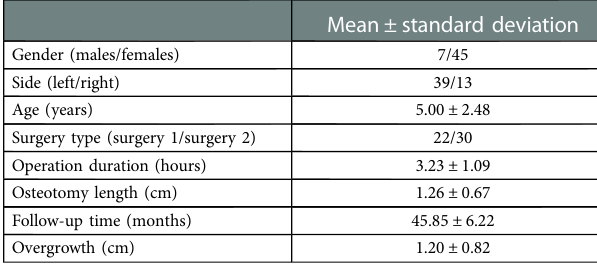
TABLE 1 Summary of patient demographics.